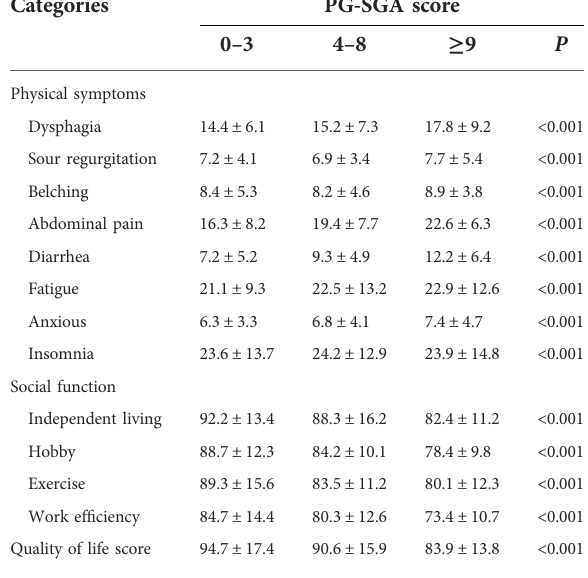
TABLE 8 Correlation between nutritional status and quality of life in gastric cancer patients 1 year after